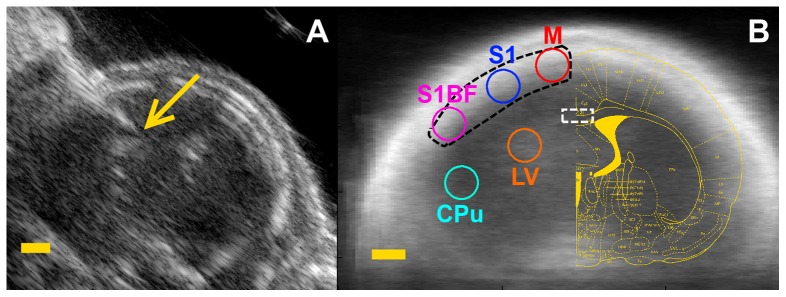
Coronal B-scan ultrasound images at the level of the LPS injection.(A) Arrow marks injection site. (B) Seeds placement, overlaid a coronal B-scan, averaged over 11 individual B-scans. Abbreviations: M, motor cortex; S1, primary somatosensory cortex; S1BF, barrel field primary somatosensory cortex; LV, Lateral ventricle; CPu, Caudate putamen. Black dotted line indicates Left Cortex ROI used for locoregional SO2 measurement. White dotted rectangle indicates ROI used for local SO2 measurement in corpus callosum. Scale bar: 1 mm.